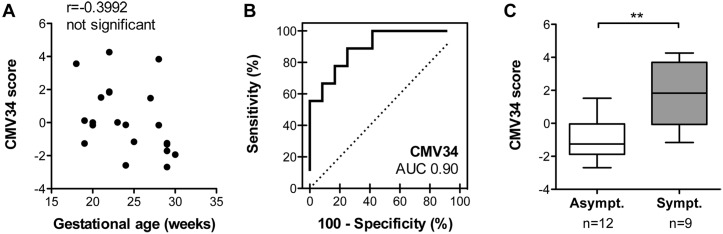
Performance of the CMV34 classifier in the validation cohort.(A) Correlation analysis of the CMV34 classifier and gestational age. (B) ROC curve for the CMV34 classifier. (C) Box-whisker plot for classification of symptomatic and asymptomatic patients in the validation set according to the CMV34 score. **p<0.01, Mann-Whitney test for independent samples.